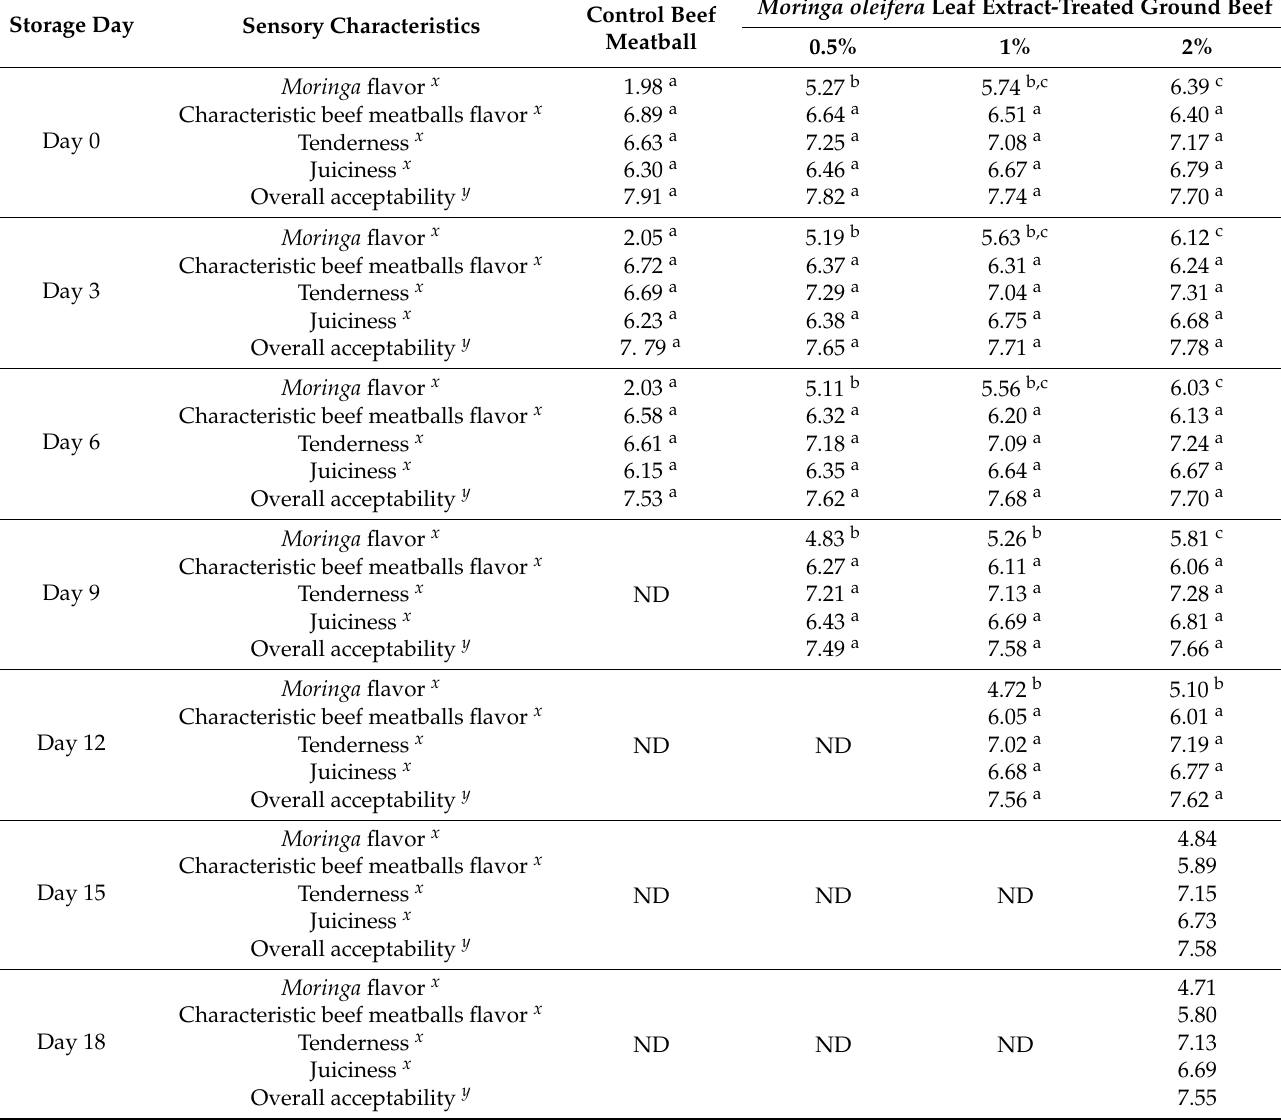
Table 2. * Mean values of the sensory characteristic score of beef meatballs treated with different concentrations of Moringa oleifera leaf extract during cold storage at 4 ◦ C for 18